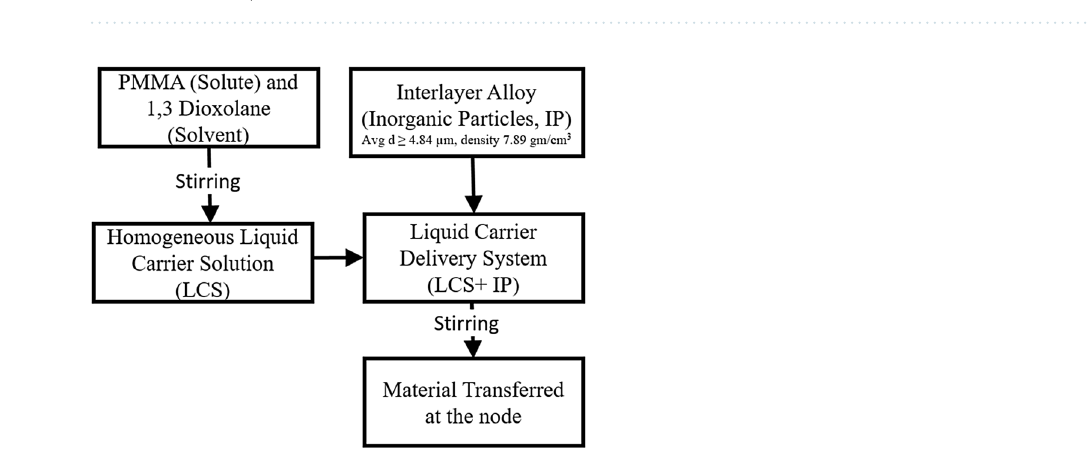
Figure 12. Liquid bridge formation in the bended wire node with carbon steel (dia:1.63 mm) and copper (dia: 1.02 and 0.51 mm). Scale bar 1 cm.